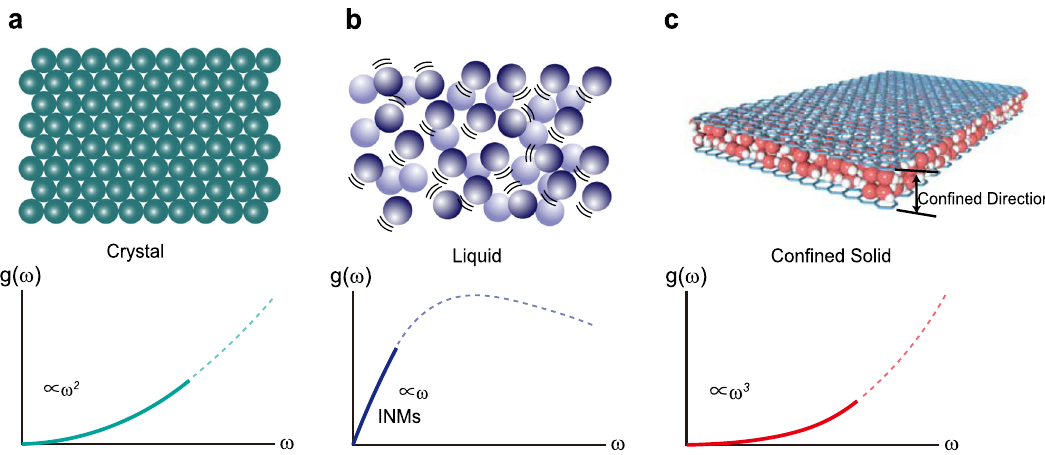
Fig. 1 The low-frequency vibrational density of states(VDOS) for three different kinds of systems. The (low frequency) VDOS g ( ω ) for ordered crystalline solids with long-range order ( a ), liquids ( b ) and slab-con fi ned solids ( c ). Ordered solids, at low frequency, display a characteristic ω 2 scaling as predicted by Debye theory. Liquids, once the diffusive contribution is removed, shows a peculiar linear scaling due to the presence of unstable instantaneous normal modes. As demonstrated in this work, slab-con fi ned solids, whether amorphous or ordered, exhibits a ω 3 scaling which is visible both in experiments and simulations and it can be explained analytically by considering simple geometric constraints on the wavevector phase space of low- energy phonon modes.